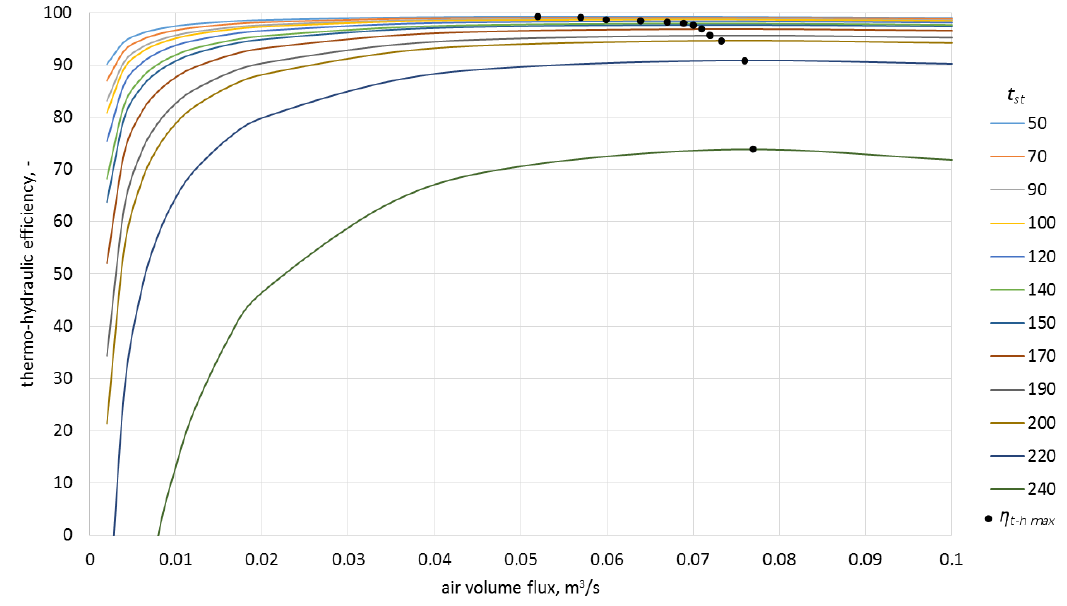
Figure 14. Thermo-hydraulic efficiency for the inlet temperature of 250 °C and various ceramic brick temperatures.